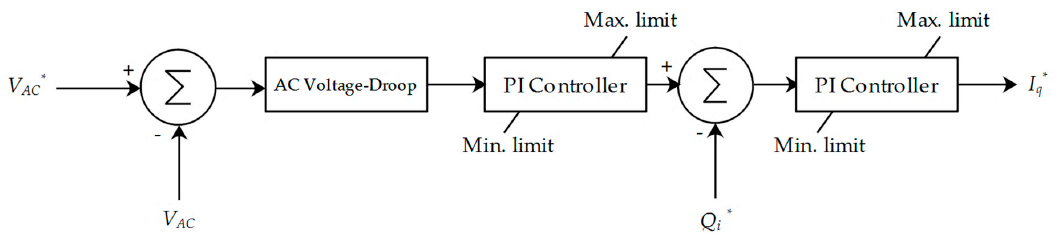
Figure 6. The proposed droop-based outer controller to obtain 𝐼 (cid:3031)∗